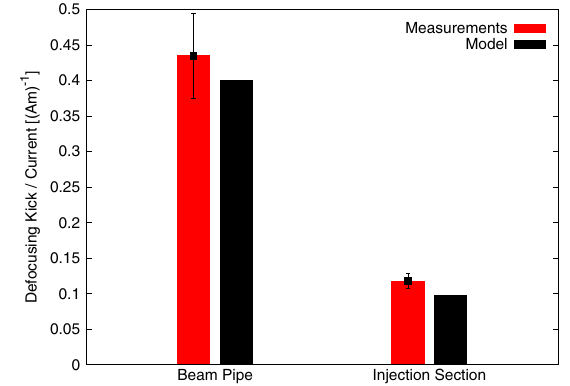
FIG. 8. In red, the defocusing kick strength per current unit obtained from the fit including the beam pipe and the injection section. Each measurement is obtained averaging over data sets containing 500 acquisitions each. The error bars represent the standard deviation of the estimated focusing kick due to the acquisition to acquisition fluctuations. In black, the predicted value from the impedance computation.